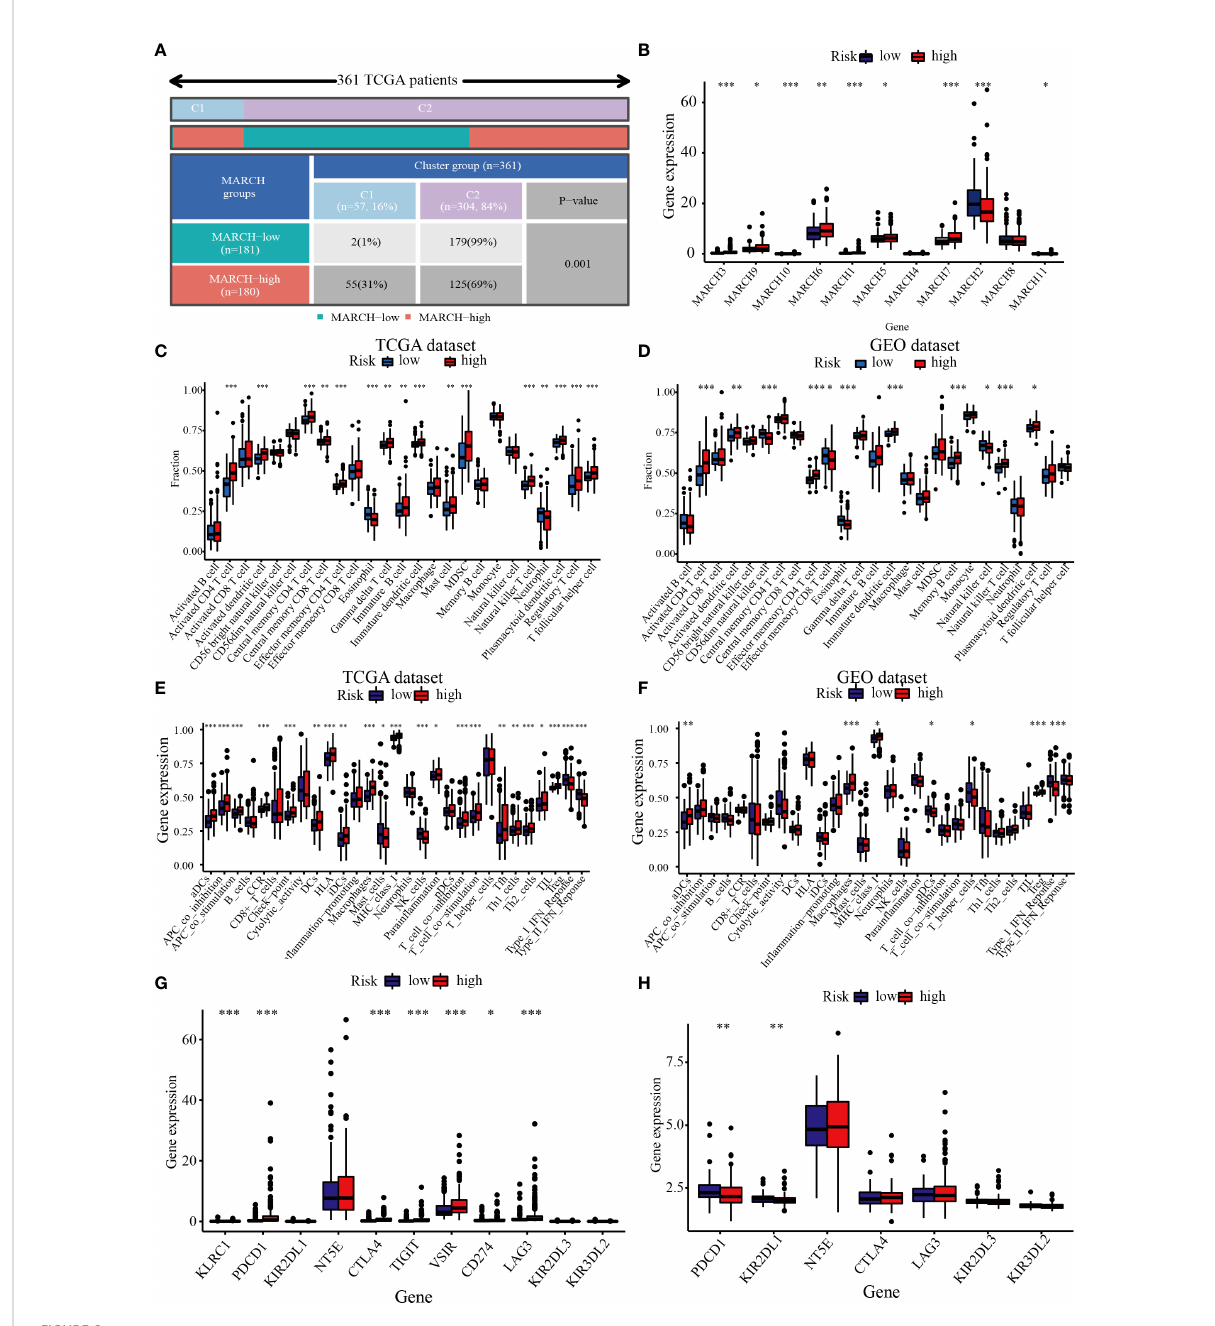
FIGURE 8 Correlation between the TIME and MARCH ligase signature. (A) The distribution of high-risk groups and low-risk groups in the C1 group and C2 group. (B) Expression of the MARCH 1 – 11 genes in the low-risk group and high-risk group. The ssGSEA results of different risk groups in the TCGA cohort (C, E) and the GEO cohort (D, F) . The 25 immune cell scores (C, D) and 13 immune-related functions (E, F) are shown in boxplots. (G, H) The relationship between risk groups and immune checkpoint expression levels. Adjusted p is shown as follows: ns, not signi fi cant; * p < 0.05; ** p < 0.01; *** p <